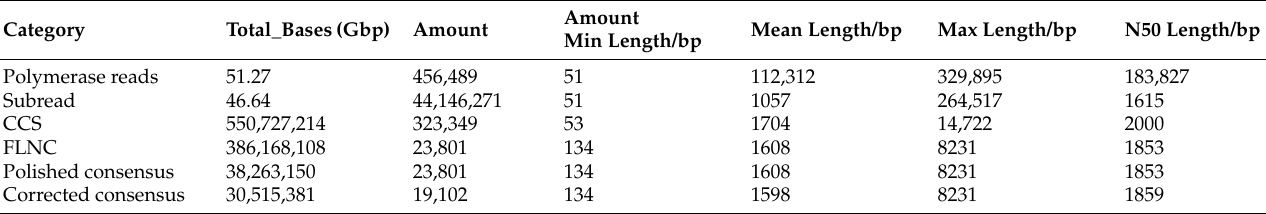
Table 1. Statistics of the SMRT sequencing